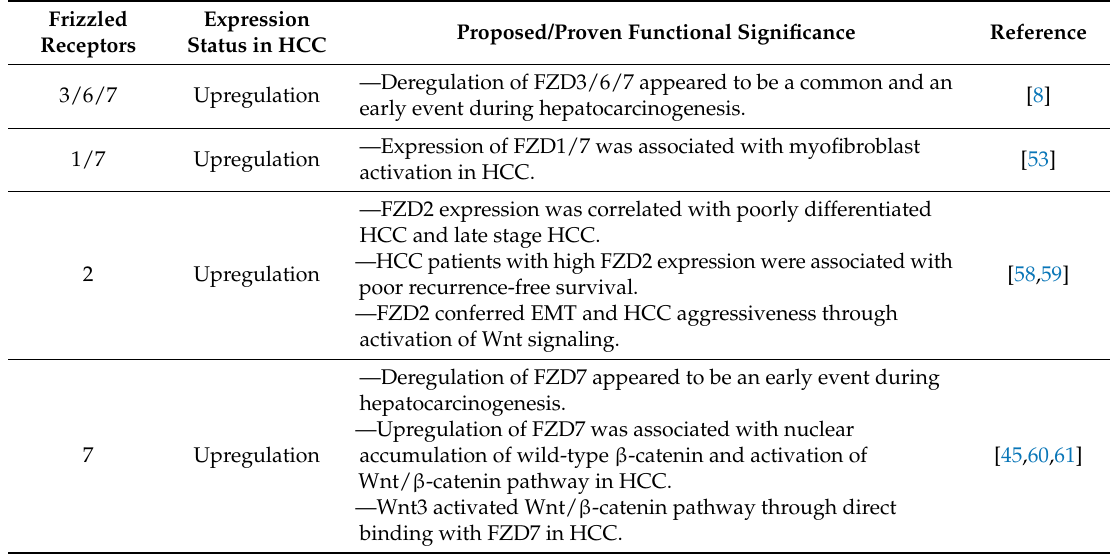
Table 1. Summary of clinical studies of Frizzled (FZD) receptors in hepatocellular carcinoma (HCC).